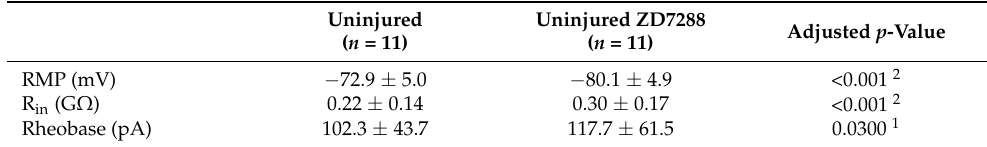
the smaller I mem highlighted by the blue arrow corresponding to increased R in in the presence of ZD7288. ( F , G ) Changes in R in occur in axotomized ( F ) and uninjured neurons ( G ) alike. ** p < 0.01; *** p < 0.001. Table 2. Effects of ZD7288 on M1LV neurons after